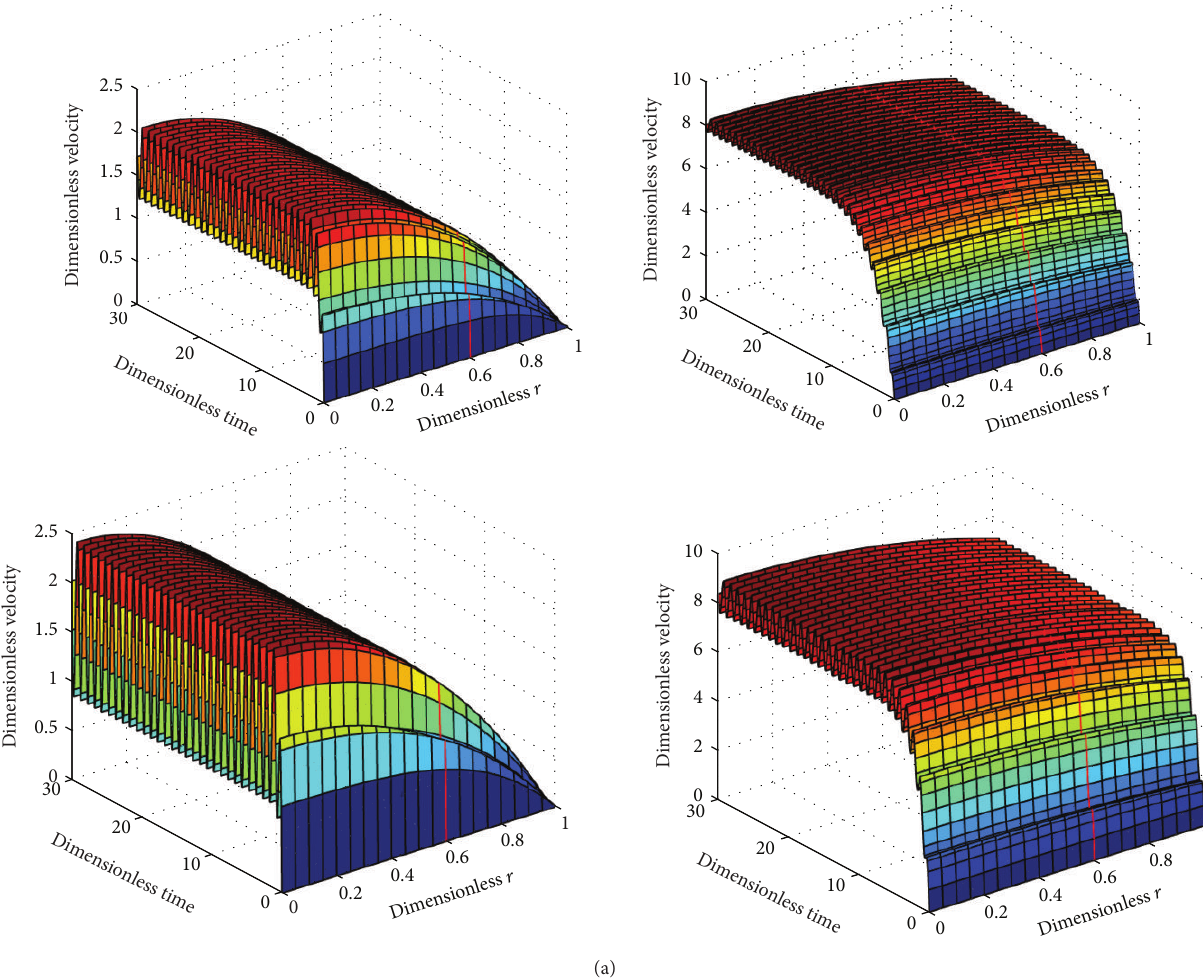
Figure 4: Velocity profiles in arteries with different radii 𝑟 : (a) 𝑟 = 0.15 cm; (b) 𝑟 = 0.5 cm. In the figure, the graphs on the left column correspond to 𝑙 𝑏 = 0 , while the graphs on the right column correspond to 𝑙 𝑏 = 2 .